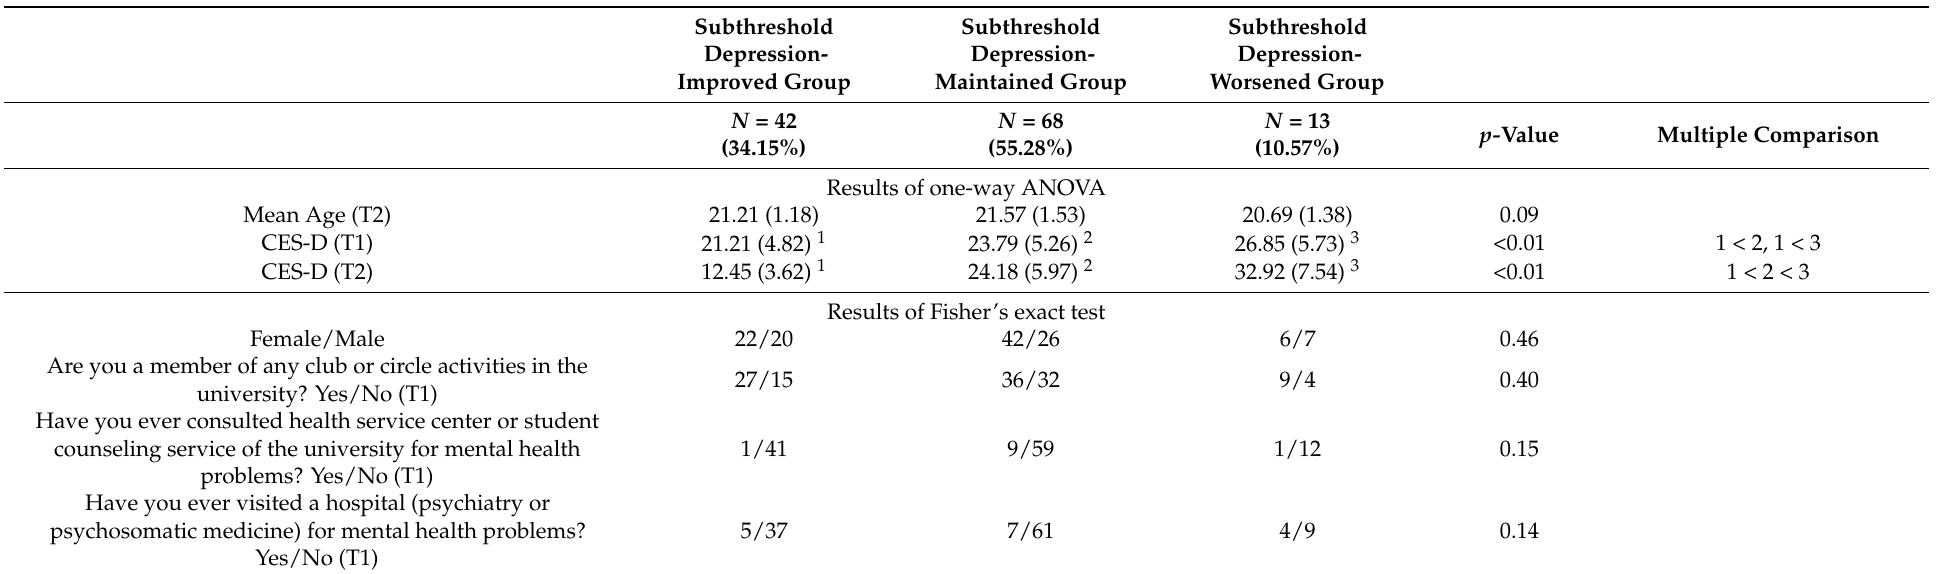
Table 1. Results of one-way ANOVA and Fisher’s exact